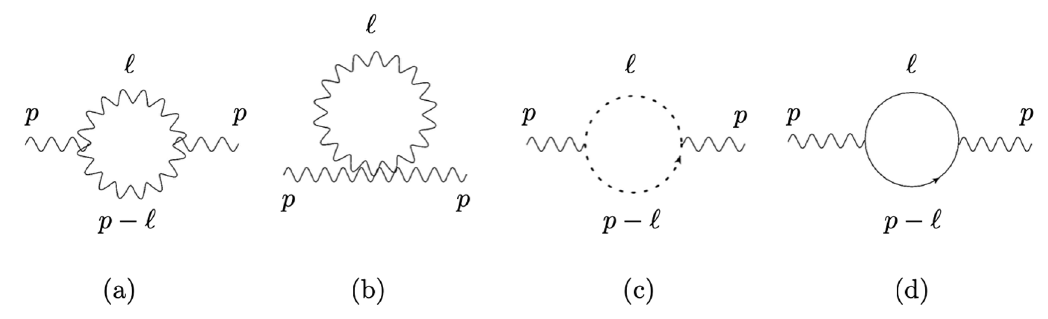
Figure 6 . Feynman diagrams for the self-energy of the gauge bosons from the loops of (a, b) the gauge bosons, (c) the ghost loops, and (d) the fermions.